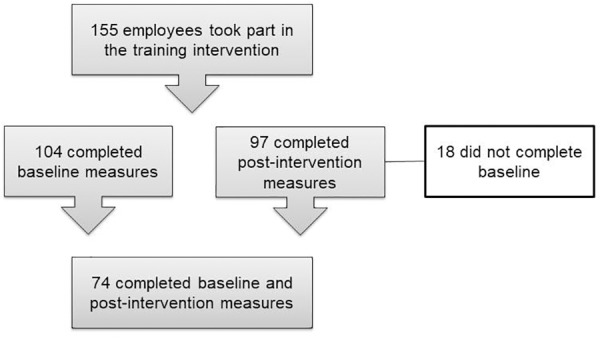
Participant flow.